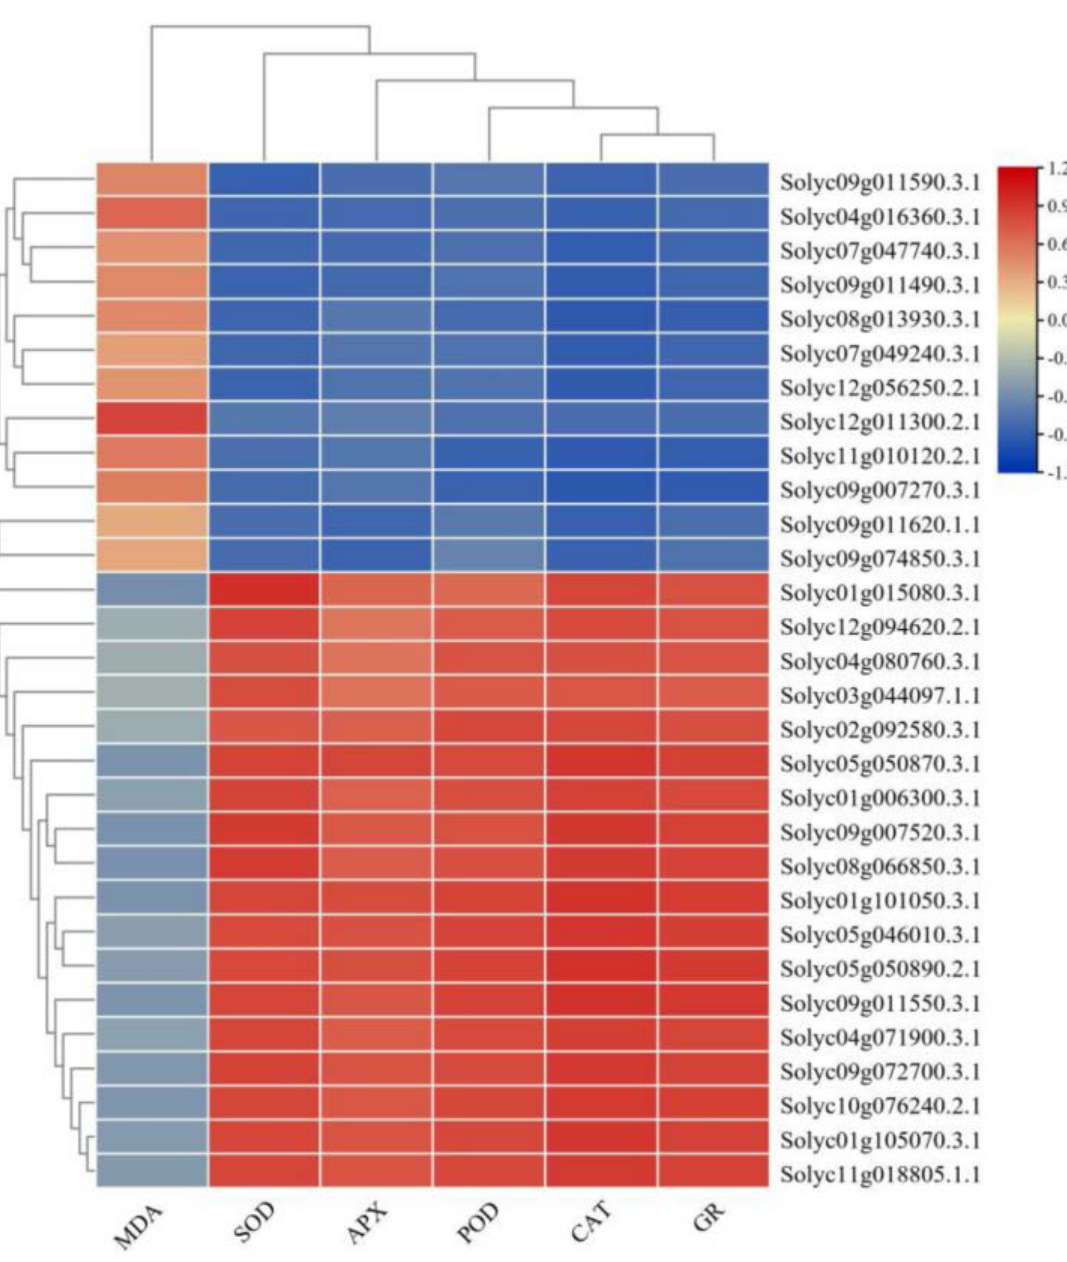
Figure 9. The heat map showing Pearson ( n ) correlation between antioxidant enzymes’ activities and their metabolism-related proteins. Color codes: red—higher correlation; blue—lower